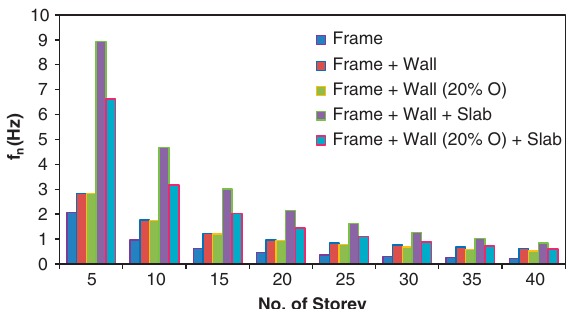
Fig. 7. Behaviour of roof displacement, D roof , considering masonry walls